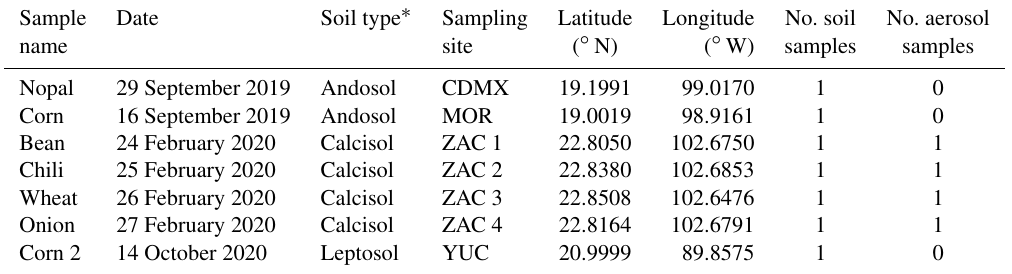
Figure 1. Map showing the sampling sites in four different states in Mexico: Mexico City (CDMX), Morelos (MOR), Zacatecas (ZAC), and Yucatán (YUC). The zoom shows the sampling spots in ZAC, along with the corresponding crops (©Google Maps 2021). Table 1. Summary of the details for the aerosol and soil samples collected in four different Mexican states: Mexico City (CDMX), Morelos (MOR), Zacatecas (ZAC), and Yucatán (YUC). The samples were labeled based on the crop previously present at the sampling location. Sample Date Soil type ∗ Sampling Latitude Longitude No. soil No.